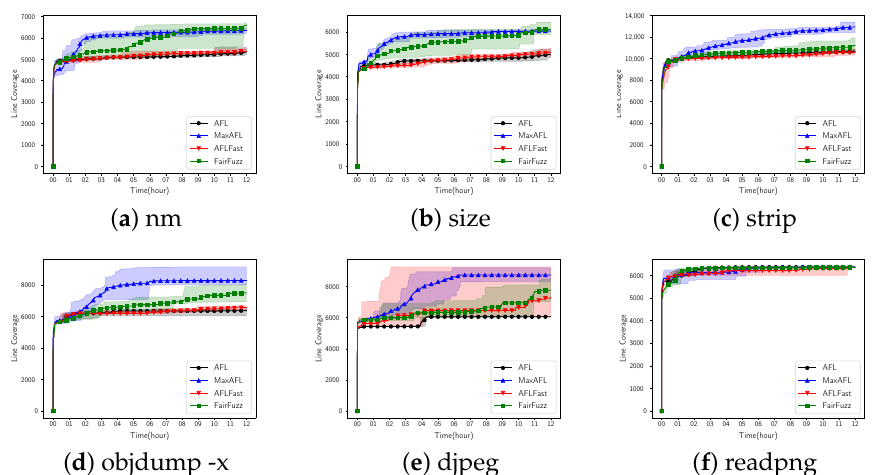
Figure 6. Line coverage per time. Each solid line is average line coverage of each fuzzer. The back- ground colors describe the range between the maximum and minimum line